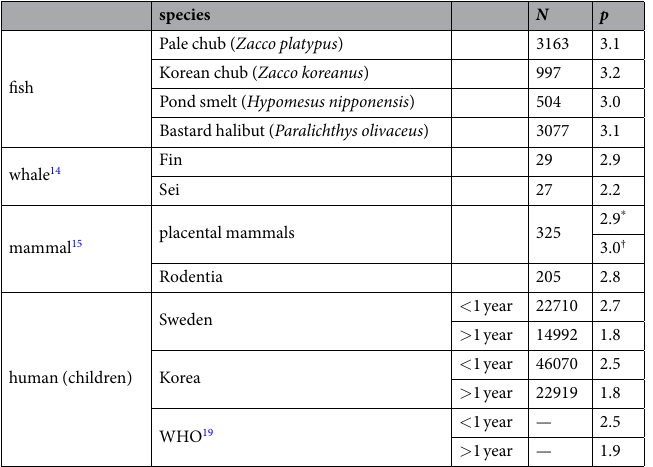
Table 1. Summarised results of Benn indices p for all datasets used in the paper. It is clear that human and other animals have different values of p . While p ≈ 3 for young infants is close to p for other animals, the value drops down to p ≈ 2 after one year. * Shoulder height, † body